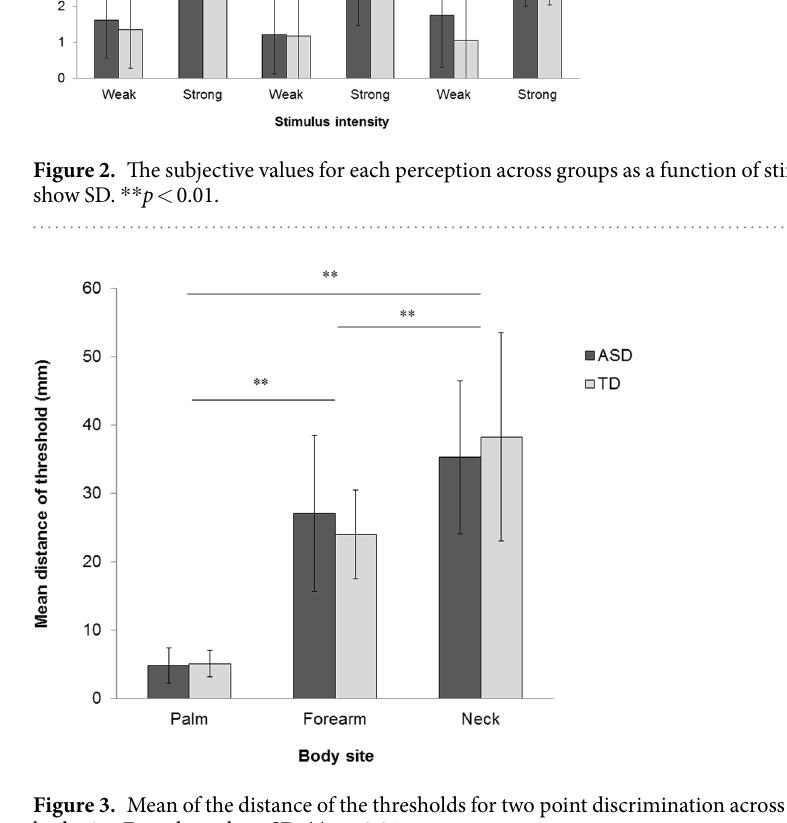
Figure 3. Mean of the distance of the thresholds for two point discrimination across groups as a function of body site. Error bars show SD. ** p <